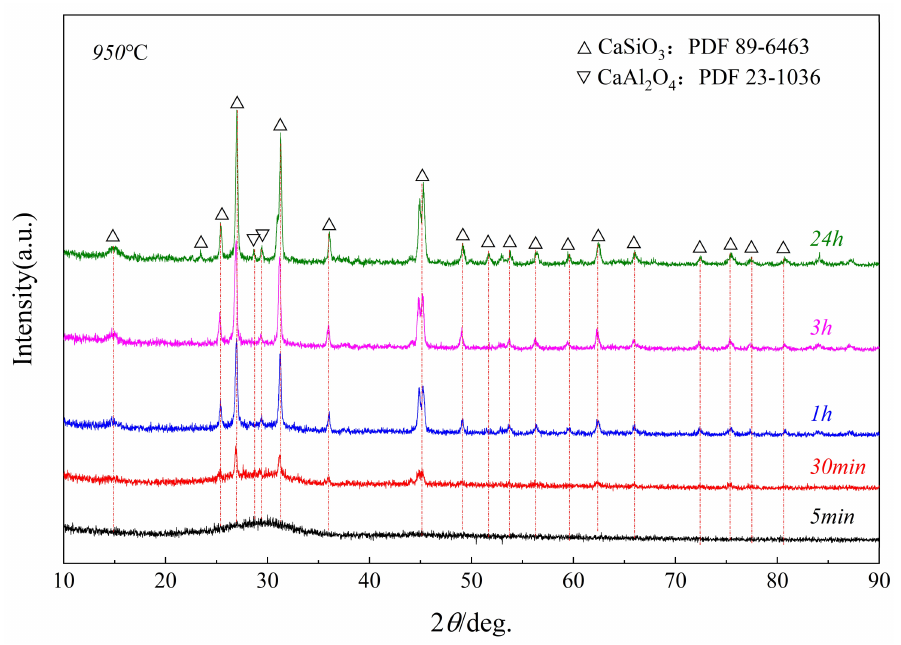
Figure 6. XRD pattern of Sample No. 3 at a constant temperature and at different times.